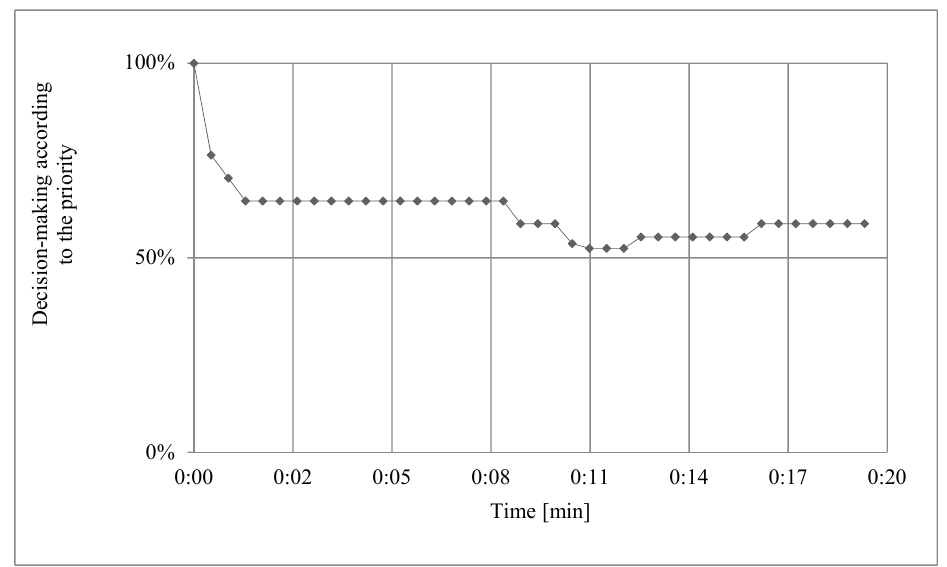
Figure 5. Graph of the probability of rational action taking against the duration of the simulation, in relation to scenario 3.